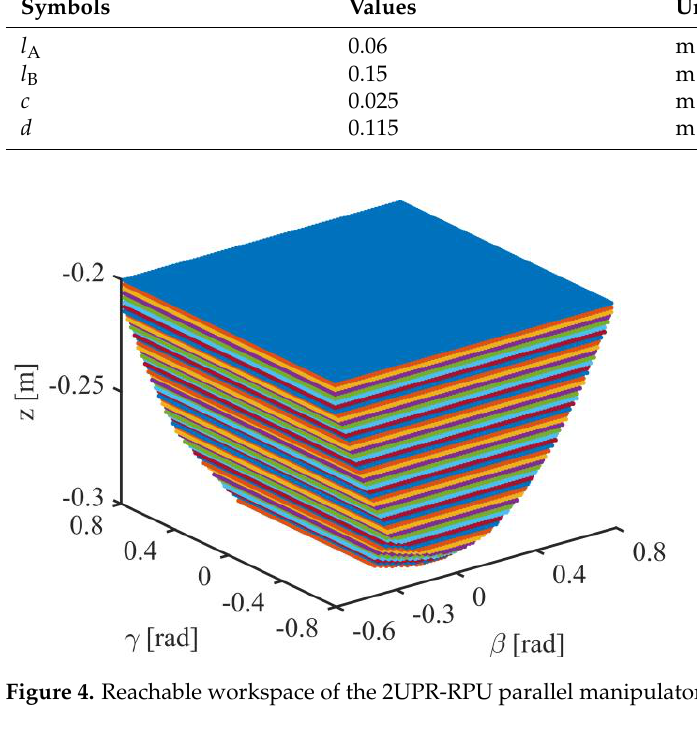
Table 6. Initially identified internal-force-and-deformation-related geometric errors. i